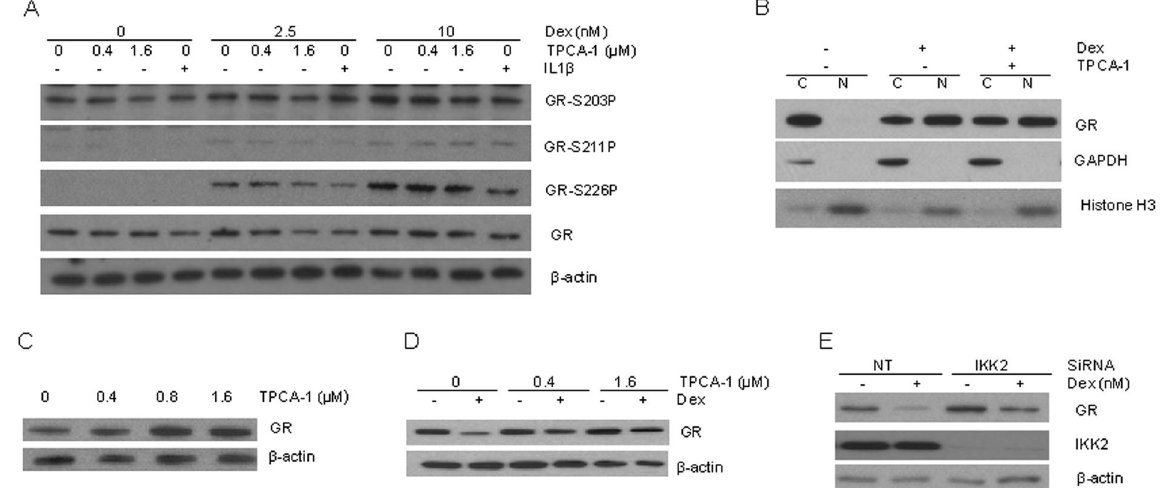
Figure 4. TPCA-1 increases GR level and impairs GR down-regulation. ( A ) TPCA-1 does not change GR phosphorylation level. A549 cells were treated for 30 min with Dex and TPCA-1 as indicated. Immunoblotting analysis was performed to measure GR phosphorylation level. ( B ) TPCA-1 does not alter Dex induced nuclear translocation of GR. A549 cells were treated as in ( A ). The cytoplasmic ( C ) and nuclear fractions (N) were prepared and analyzed using immune- blotting to assay GR level. GAPDH and histone H3 were applied as internal standards for cytoplasmic and nuclear fractions, respectively. ( C ) TPCA-1 increases GR level. A549 cells were treated with different concentrations of TPCA-1 for 48 h and crude cell extract was immune-blotted to measure GR level. ( D ) TPCA-1 impairs Dex induced GR down-regulation. A549 cells were treated with Dex and TPCA-1 as indicated, and GR level was analyzed. ( E ) IKK2 modulates GR level and down-regulation. A549 cells were transfected with Non-targeting (NT) or IKK2 siRNA for 48 h, and then treated with Dex